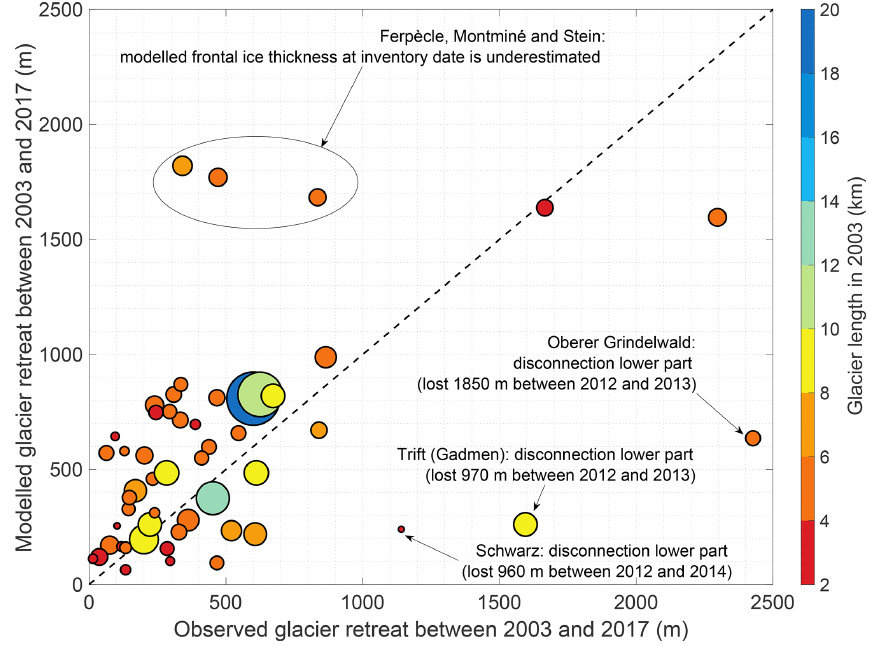
Figure 7. Observed vs. modelled glacier retreat (length change) between 2003 and 2017 for all 52 glaciers longer than 3km monitored by GLAMOS (Glaciological Reports, 1881–2017). Point size is proportional to glacier area (as is the case for the colour